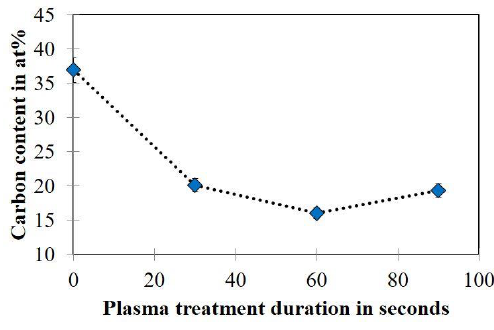
Fig. 3. Carbon content of sapphire surfaces vs. plasma treatment duration .